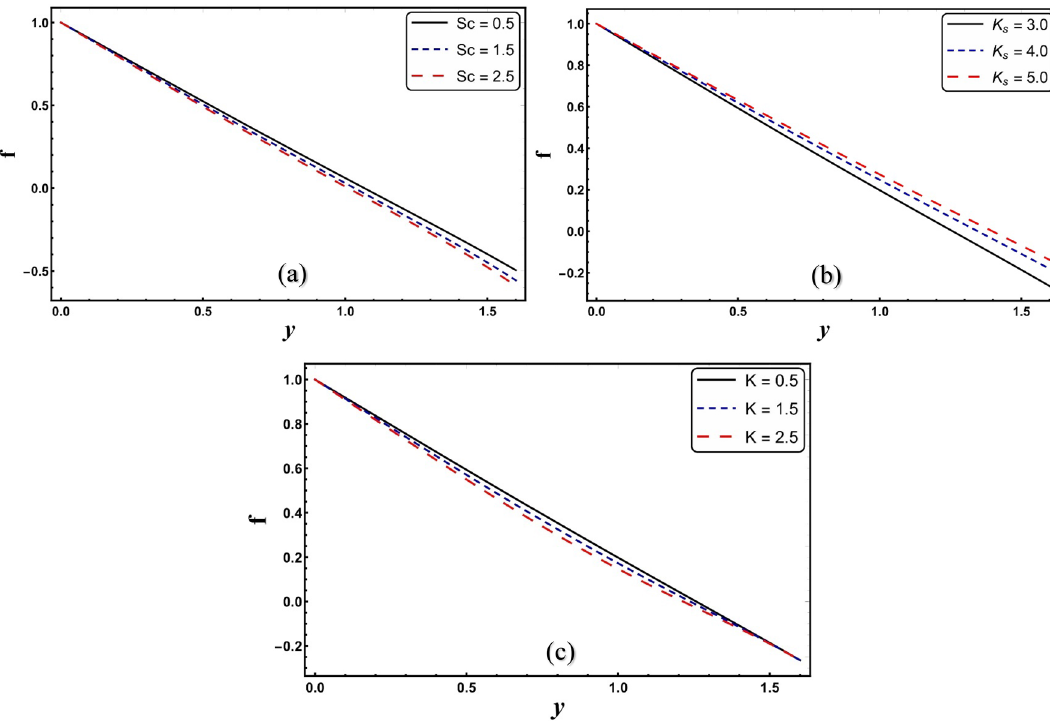
Figure 3. ( a – c ) Velocity profile for change in different embedded